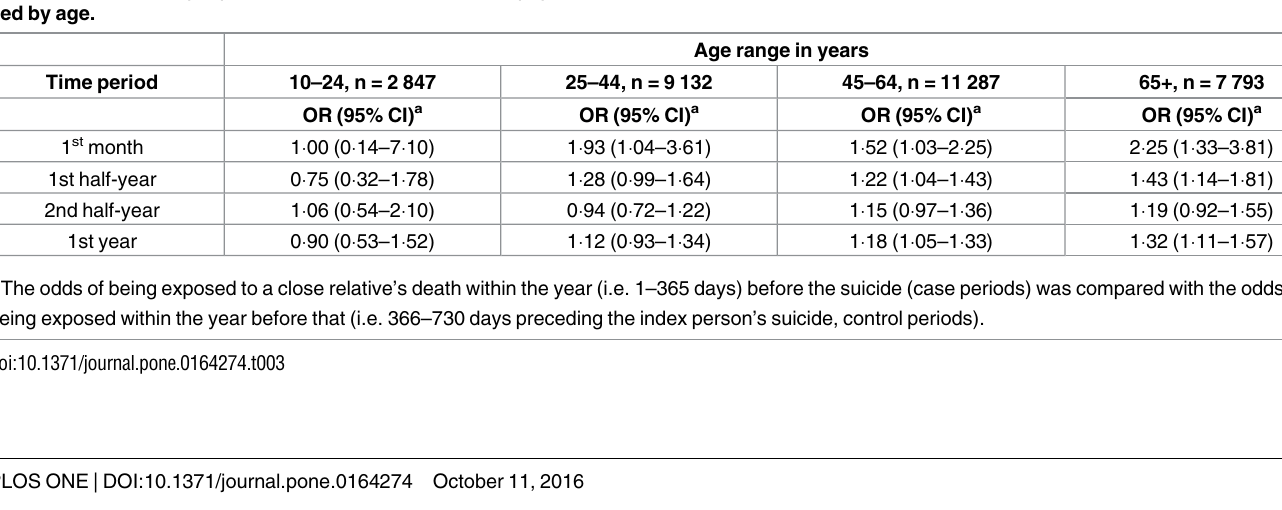
Table 3. Odds ratios (OR) and 95% Confidence Intervals (CI) of suicide after death of a close relative in 31 059 suicide victims in Sweden, strati- fied by age. Time